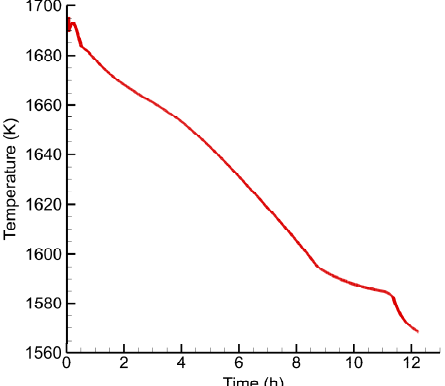
Figure 2. The temperature history in the center at the bottom of the crystal.